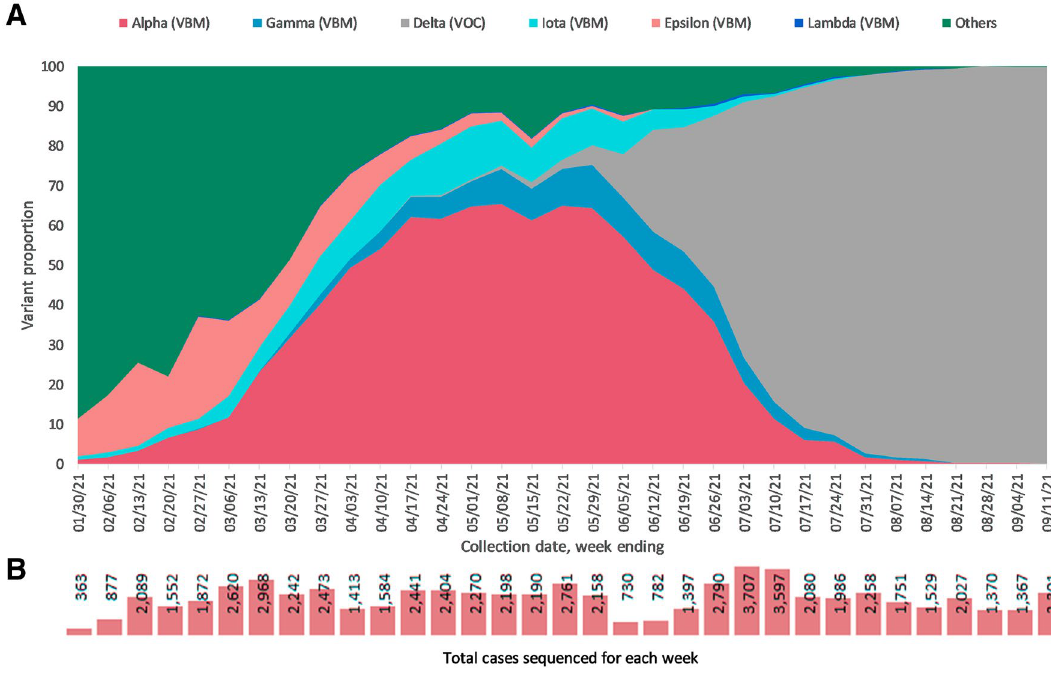
Figure 5. Weekly proportions of SARS-CoV-2 variants. ( A ) Variant proportions were calculated against total cases sequenced each week. ( B ) Total number of cases sequenced for each week is indicated with scale